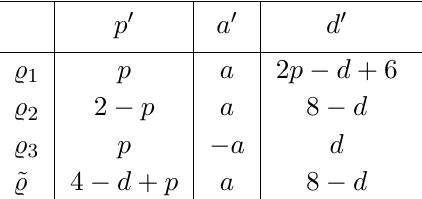
Table 3 . The action of symmetries in table 1 on the parameters ( p; a ; d ) that characterize a con(cid:12)guration of two scalar bulk (cid:12)elds in the presence of a single defect. As in table 1 the symmetry transformation ~ % is accompanied by a shift of